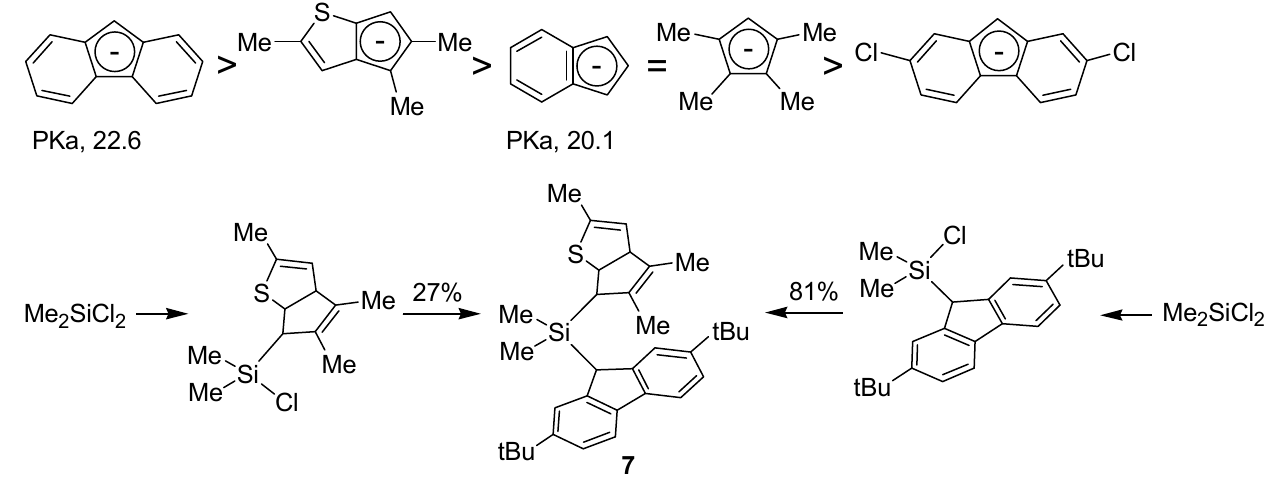
Scheme 5. Basicity order derived from 1 H NMR studies ( top ) and the yield improvement by reversing the reaction sequence ( bottom ).